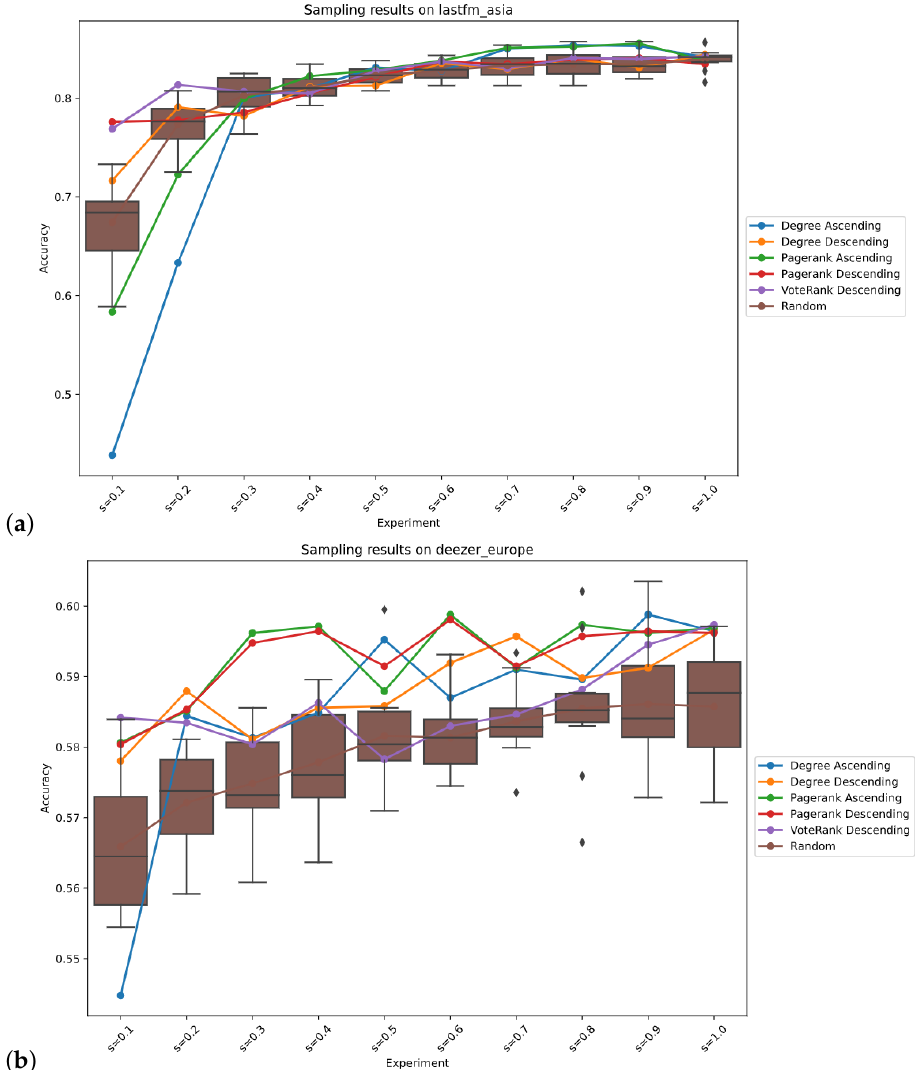
Figure 5. Here the accuracy of the model for the node percentages samples is presented using the different node directions on LastFm data ( a ) and Deezer-Europe data ( b ). The performance of this pipeline on the Deezer_Europe social media dataset (plot b ) is unusual in that almost all sampling methods are uniformly better than random